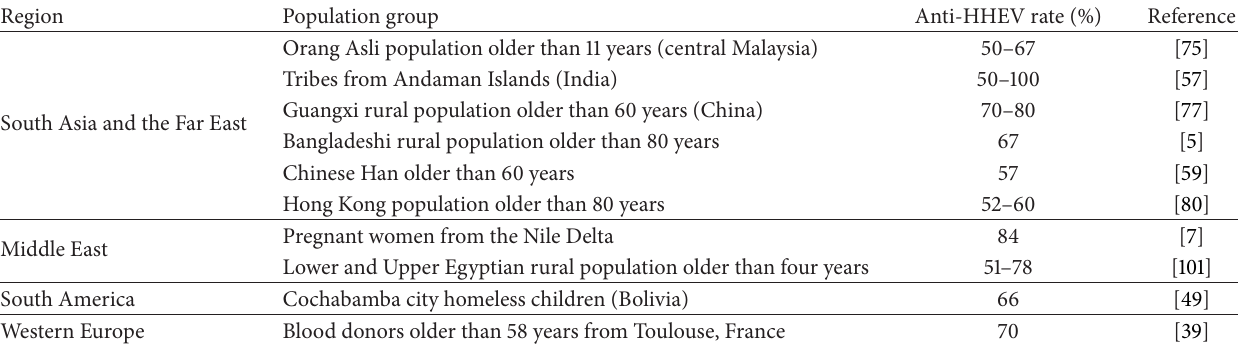
Table 7: Studies reporting anti-HHEV prevalence higher than 50% among specific population